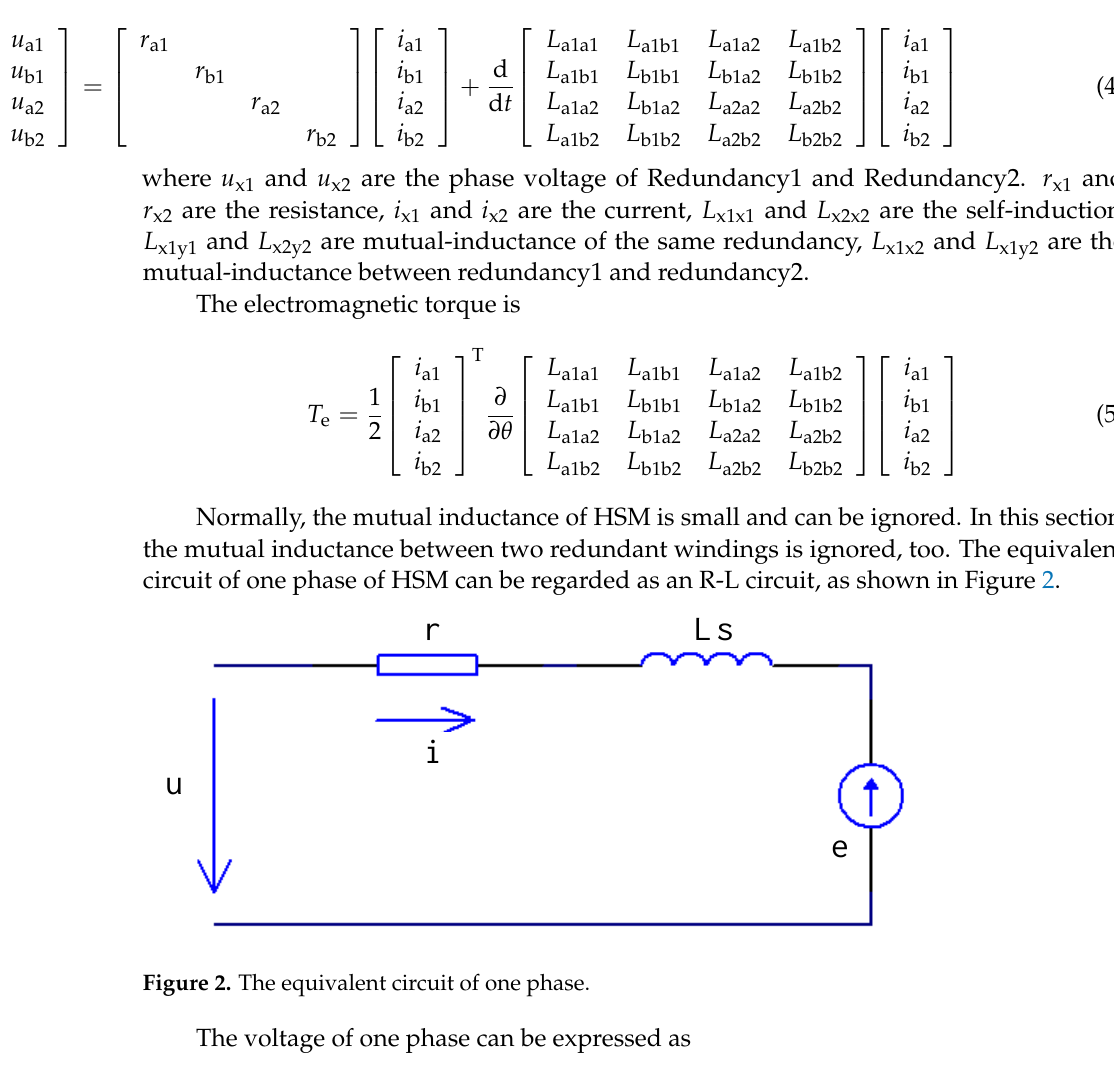
where ψ m is the maximum magnetic flux, p is the number of pole